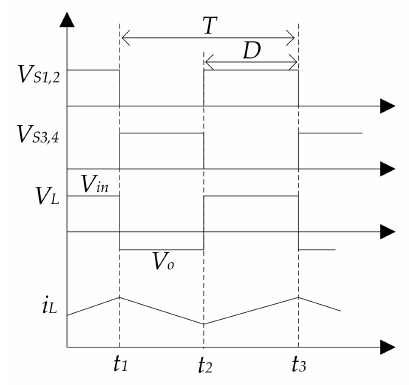
Figure 3. Synchronization control